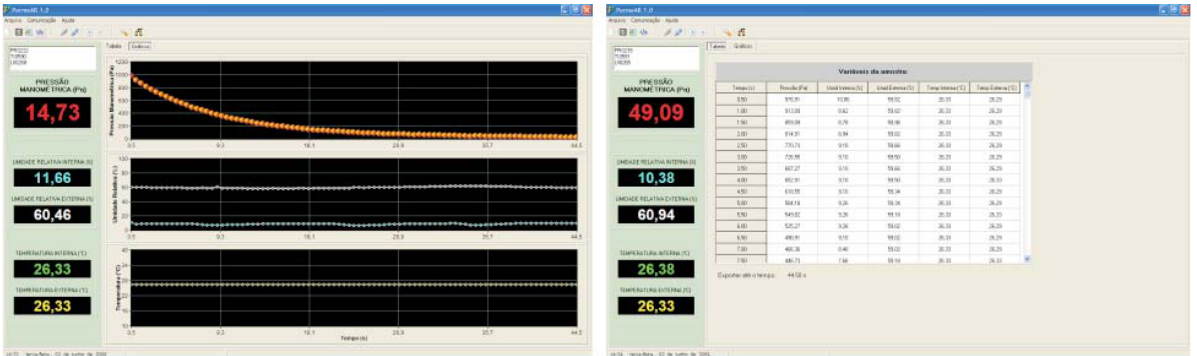
Figura 2. Janelas principais do programa computacional PermeAR v.1.0 com mostradores instantâneos da pressão manométrica, temperaturas e umidades relativas, interna e externa, e gráficos obtidos durante o processo de medição.